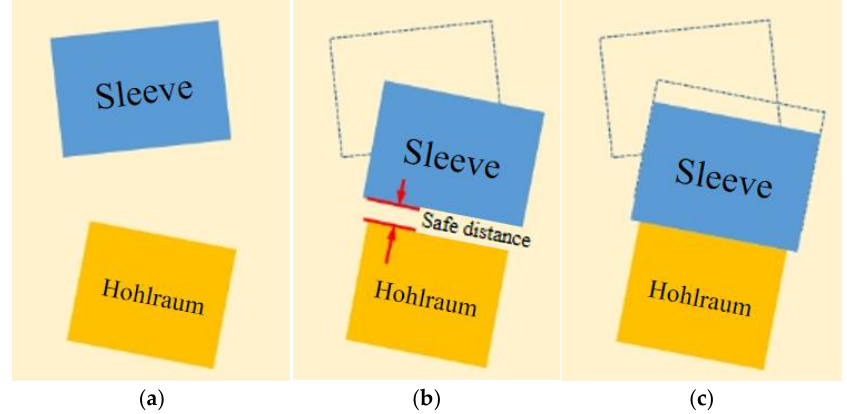
Figure 7. Posture adjustment status of TMP component and hohlraum. ( a ) Parts without attitude adjustment; ( b ) Parts with attitude adjustment; ( c ) Parts after contact.